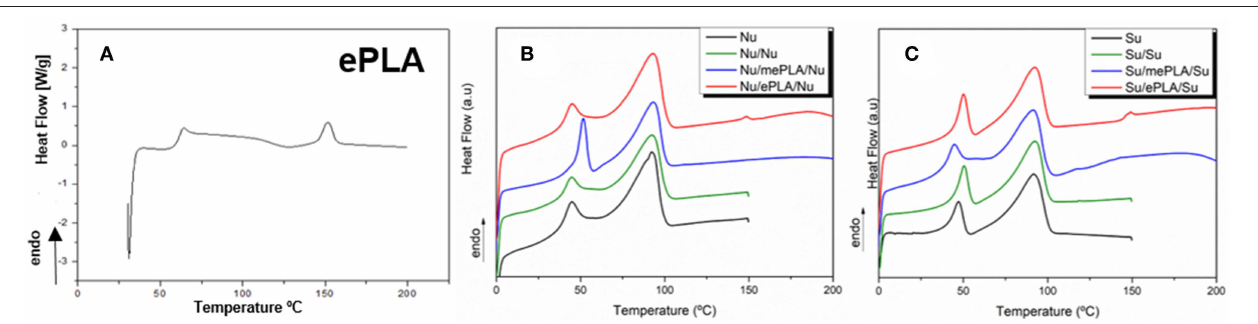
Frontiers in Materials |